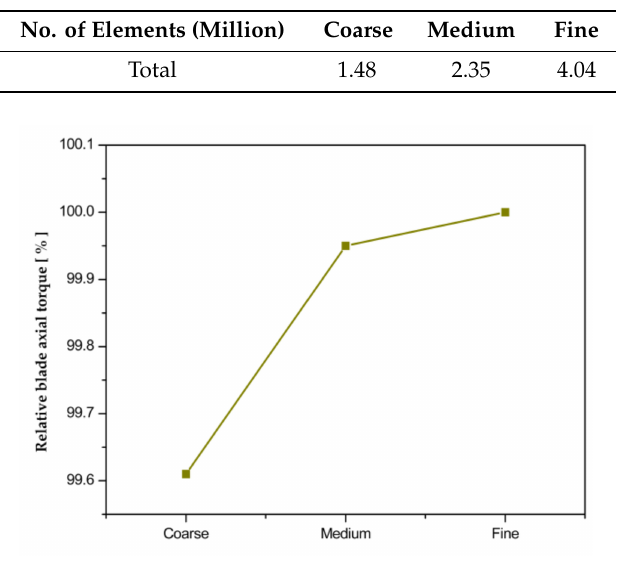
Figure 4. Surface mesh: ( a ) mesh on the blade and ( b ) mesh around the tubercles. Table 3. The mesh size used for the check of mesh sensitivity.